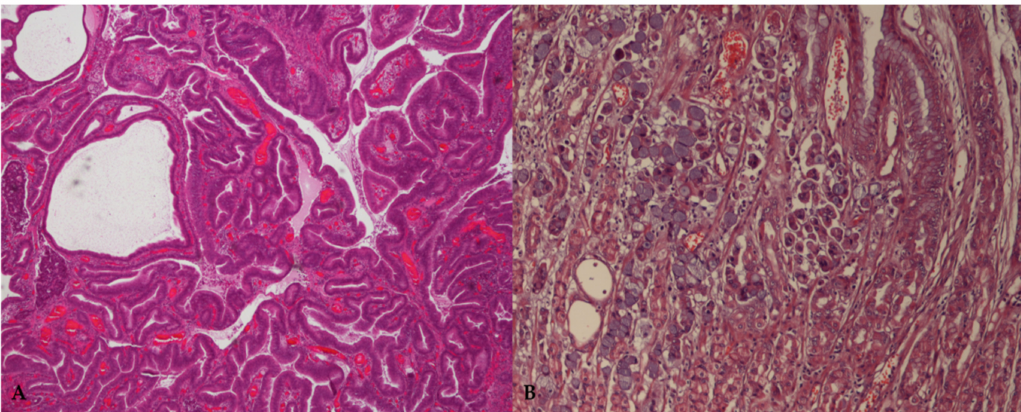
Figure 1. Representative microphotographs of the main histological variants of canine gastric car- cinoma. ( A ) Tubulopapillary or intestinal type, according to the WHO and Lauren classification, respectively. HE = 40 × . ( B ) Signet ring cell carcinoma or diffuse type, according to the WHO and Lauren classification, respectively. HE = 100 × .